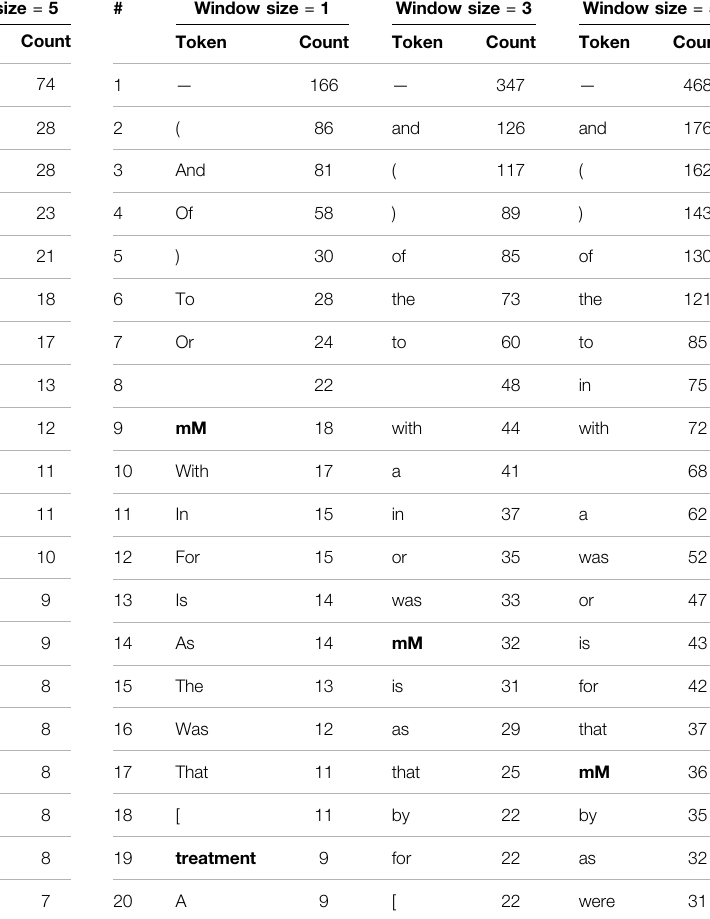
TABLE 6 | The 20 most frequent tokens, including stop words and punctuation marks, within various window sizes around entities incorrectly labeled by the Keras model. Words that are neither stop words nor punctuation words are in